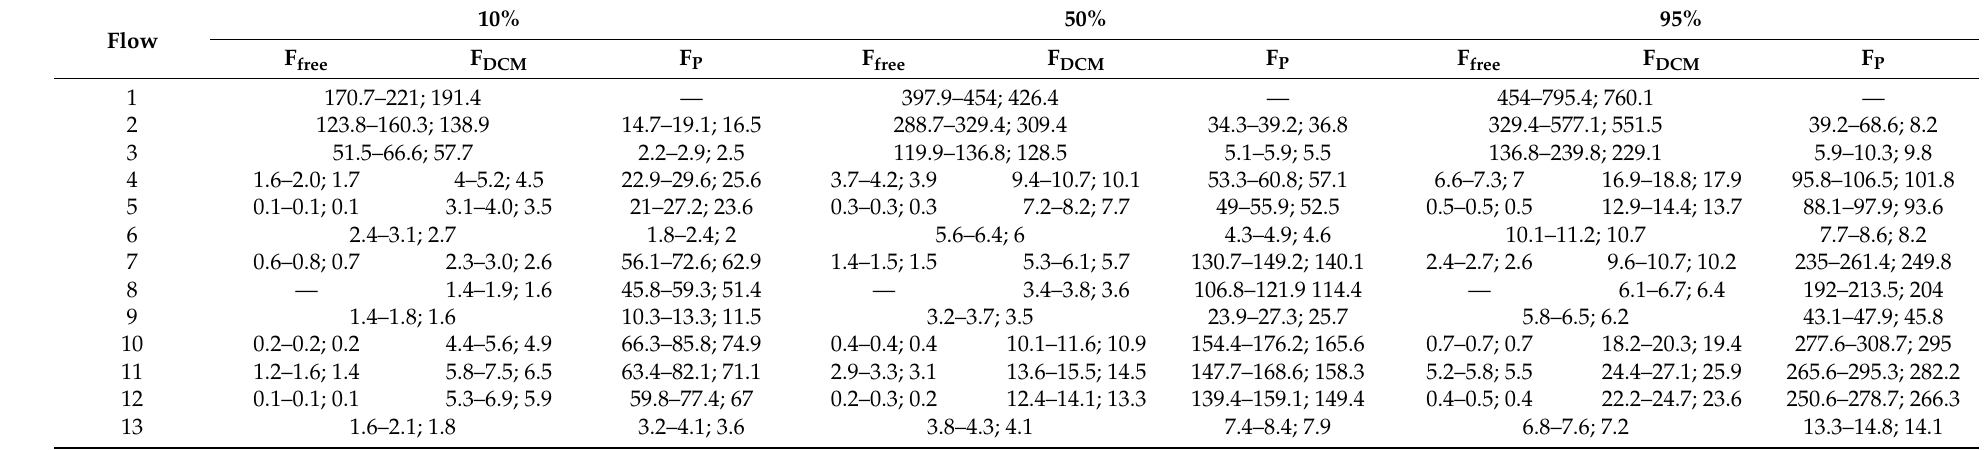
Table 4. Fate of naphthalene in the modeled WWTP. Results are presented in g/day for 10%, 50%, and 95% percentiles. Combined values for flows 1, 2, 3, 6, 9, and 13 correspond to the aqueous phase (See Figure 1). Data are shown as min–max; median.